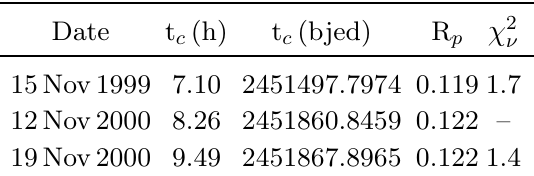
Table 1. Best fit parameters from the three transit light